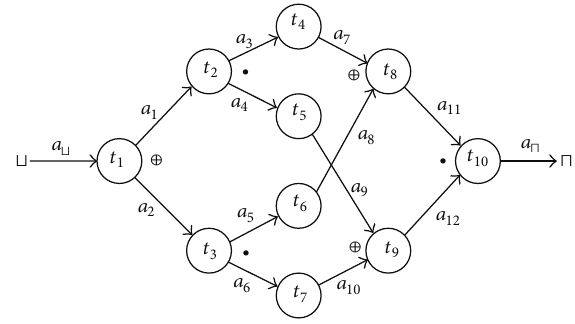
Figure 3: Example of a